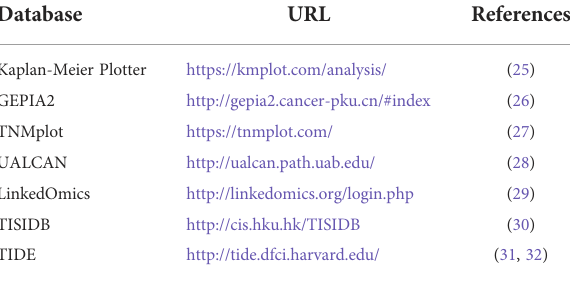
TABLE 2 The bioinformatics databases analyzed in this study.